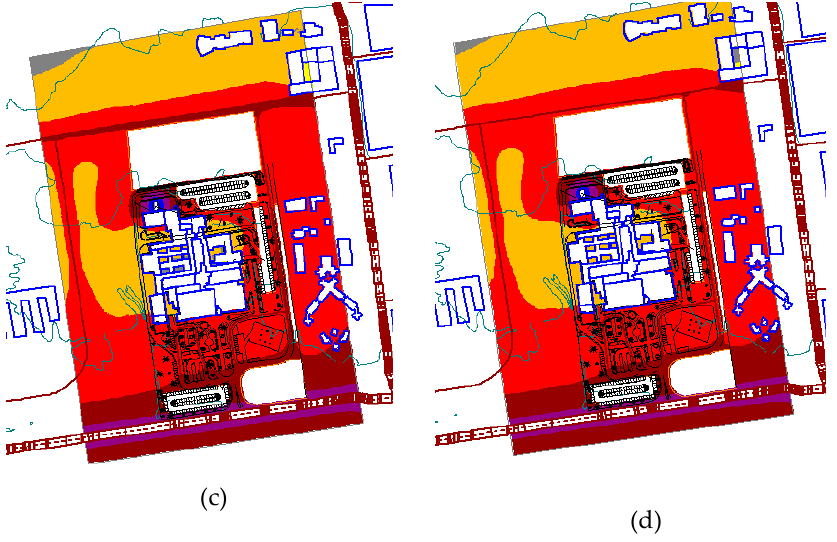
Figure 8. Noise propagation model at different heights. ( a ) H = 1.5 m; ( b ) H = 4.0 m; ( c ) H = 7.0 m; ( d ) 10.0 m.